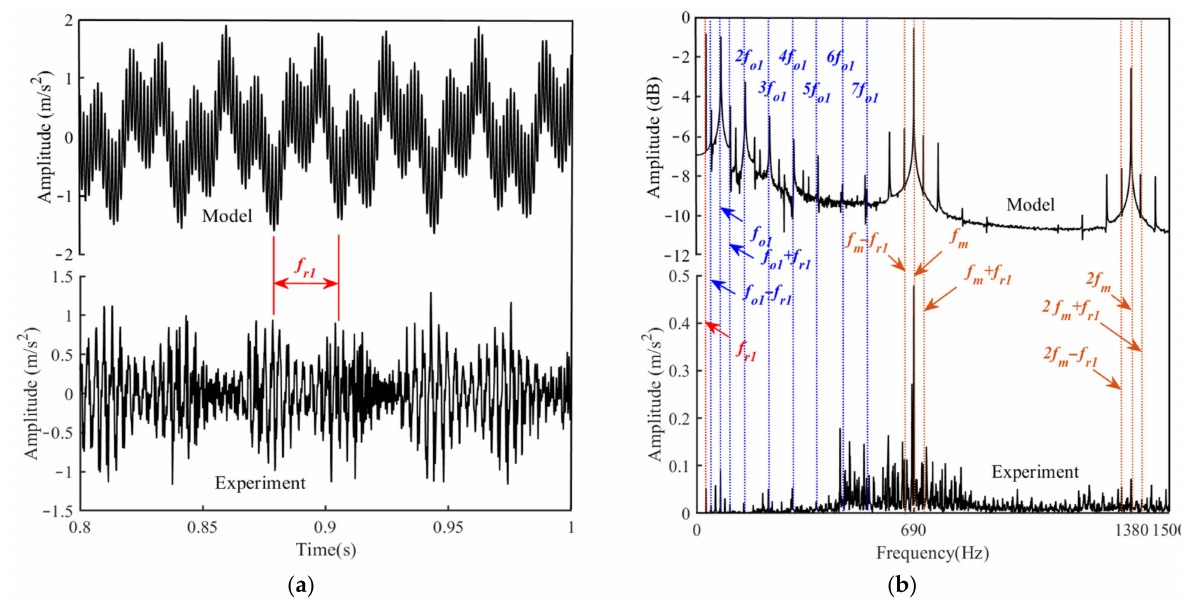
Figure 7. The comparison between experiment and simulation: ( a ) time-domain response; ( b ) frequency- domain